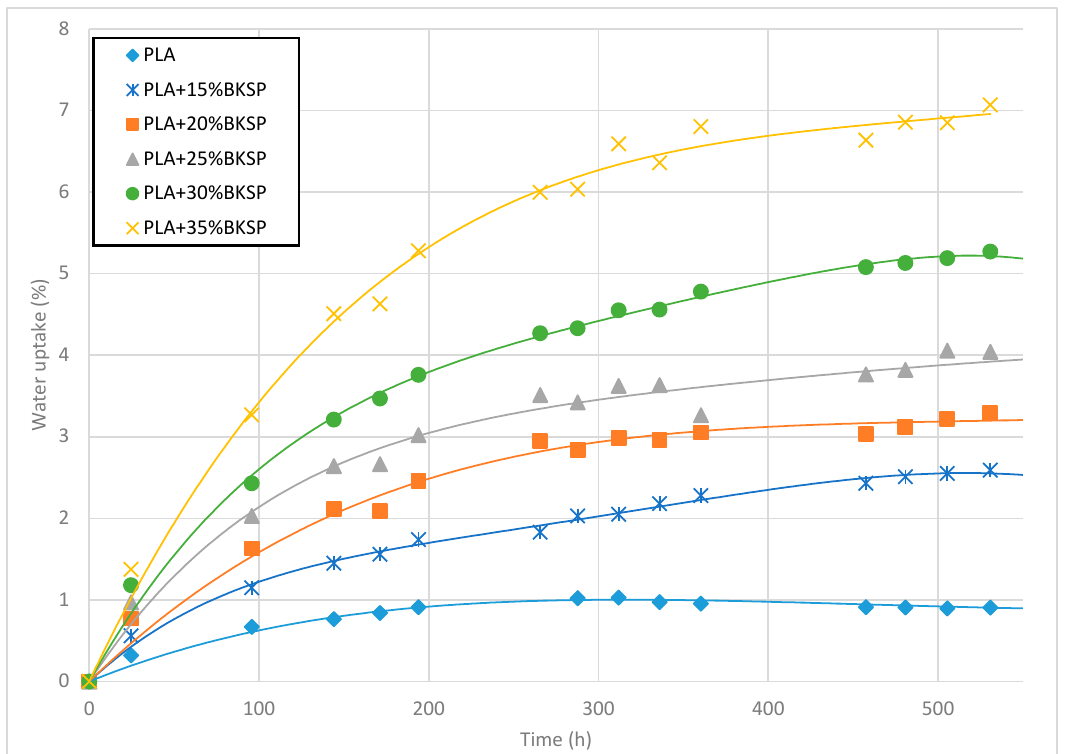
Figure 7. Water uptake behavior of PLA and PLA-BKSP composites.